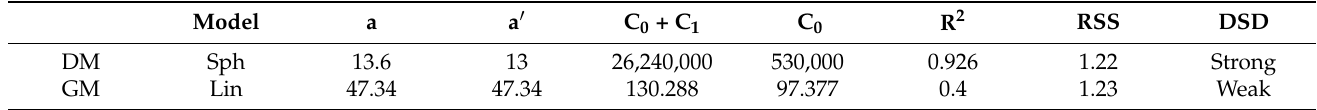
Table 4. Model and semivariogram parameters, adjusted to obtain values from dry and green matter (ton/ha − 1